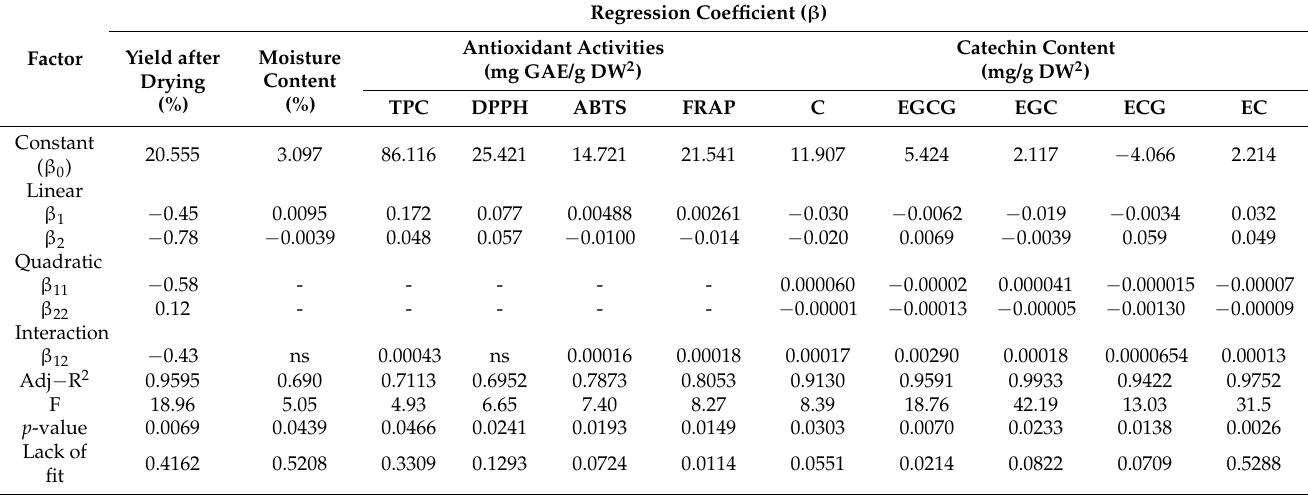
Table 2. Regression equations for the responses affected by roasting temperature and time, and